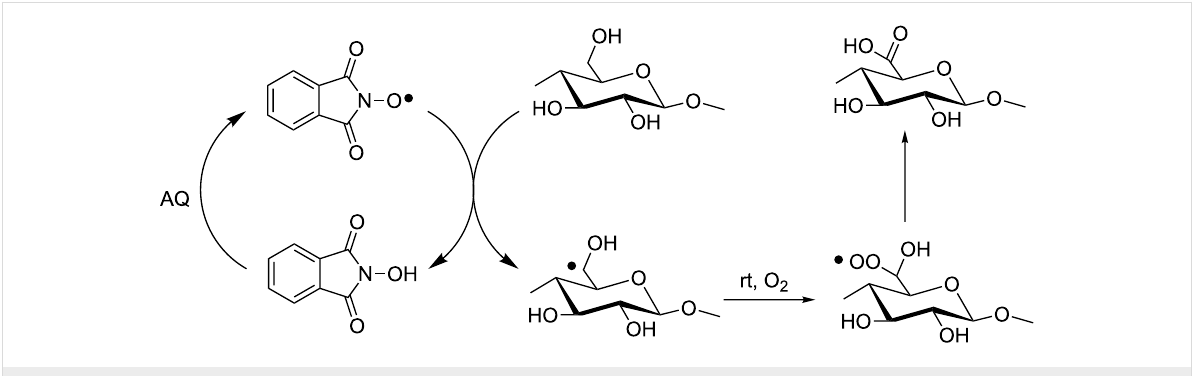
Scheme 17: NHPI/AQ mediated aerobic oxidation of cellulose fibers.